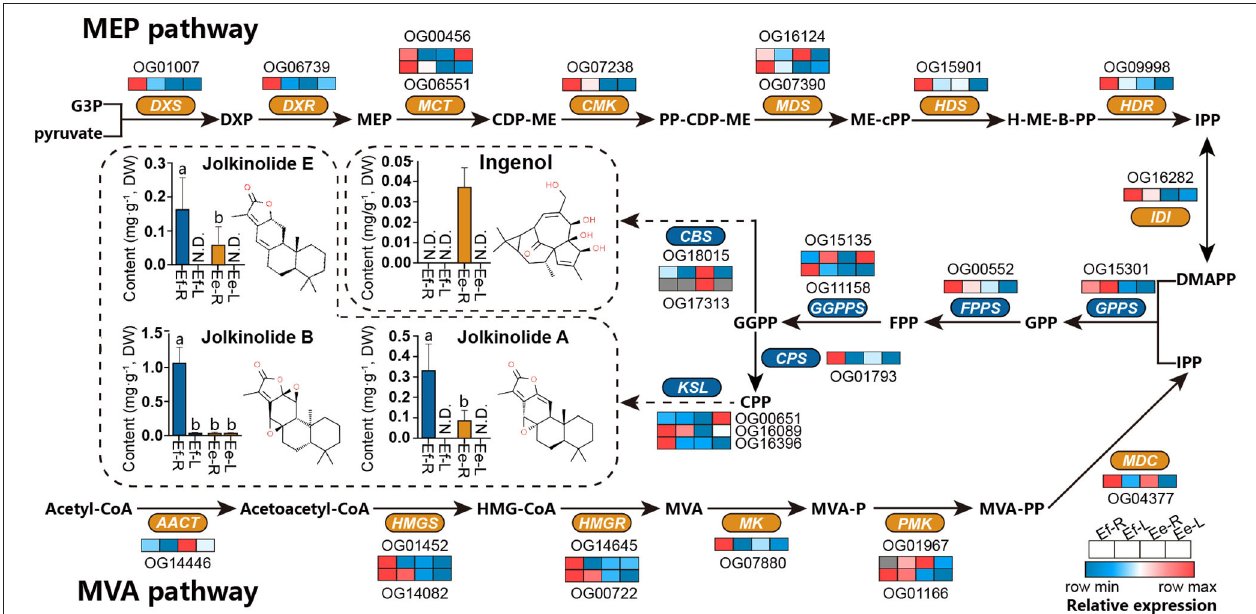
FIGURE 7 | Differences in active ingredients and the expression levels of orthologous genes in E. fischeriana and E. ehracteolata . MVA pathway, the mevalonate pathway; Acetyl-CoA, acetyl coenzyme A; acetoacetyl-CoA, acetoacetyl coenzyme A; HMG-CoA, 3-hydroxy-3-methylglutaryl CoA; MVA, mevalonate; MVA-P, mevalonate-5-phosphate; MVA-PP, mevalonate-5-diphosphomevalonate; IPP, isopentenyl pyrophosphate; MEP pathway, the 2-C-methyl- d -erythritol 4-phosphate pathway; G3P, glyceraldehyde 3-phosphate; DXP, 1-deoxy-d-xylulose 5-phosphate; MEP, 2-C-methyl-d-erythritol 4-phosphate; CDP-ME, 4-(cytidine 5’-diphospho)-2-C-methyl- d -erythritol; PP-CDP-ME, 2-phospho-4-(cytidine 5’-diphospho)-2-C-methyl-d-erythritol; ME-cPP, 2-C-methyl-d-erythritol 2,4-cyclodiphosphate; H-ME-B-PP, 1-hydroxy-2-methyl-2-butenyl 4-diphosphate; DMAPP, dimethylallyl pyrophosphate; GPP, geranyl diphosphate; FPP, farnesyl diphosphate; GGPP, geranylgeranyl diphosphate; CPP, copalyl diphosphate; AACT, acetoacetyl-CoA transferase; HMGS, hydroxymethyl-glutaryl-CoA synthase; HMGR, 3-hydroxy-3-methylglutaryl CoA reductase; MK, mevalonate kinase; PMK, phosphomevalonate kinase; MDC, mevalonate-5-pyrophosphate decarboxylase; DXS, 1-deoxy-d-xylulose-5-phosphate synthase; DXR, 1-deoxy-d-xylulose-5-phosphate reductoisomerase; MCT, 2-C-methyl-D-erythritol 4-phosphate cytidylyltransferase; CMK, 4-(cytidine 5’-diphospho)-2-C-methyl-d-erythritol kinase; MDS, 2-C-methyl-d-erythritol 2,4-cyclodiphosphate synthase; HDS, 4-hydroxy-3-methylbut-2-enyl diphosphate synthase; HDR: 4-hydroxy-3-methyl-but-2-enyl diphosphate reductase; IDI, Isopentenyl-diphosphate delta-isomerase; GPPS, GPP synthase; FPPS, FPP synthase; GGPS, GGPP synthase; CPS, copalyl diphosphate synthase; KSL, kaurene synthase-like; CBS, casbane synthase. N.D., below detection limit. Different letters denote statistically significant differences (ANOVA/LSD, P <